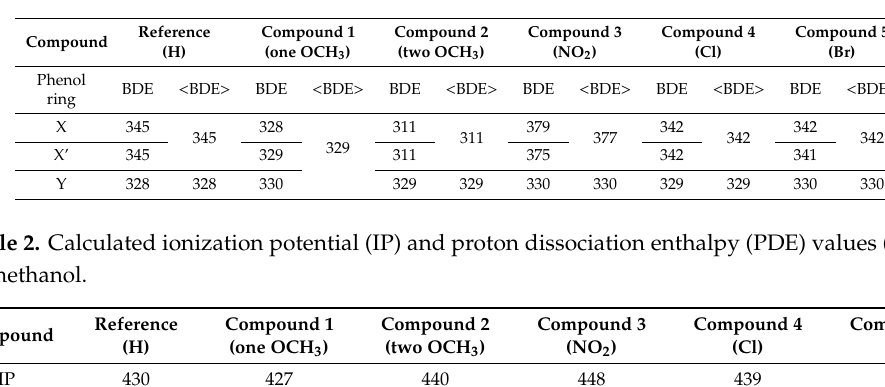
Table 1. Calculated O–H bond dissociation enthalpy (BDE) values (kJ / mol) of the phenol rings (X, X’, and Y) in methanol.